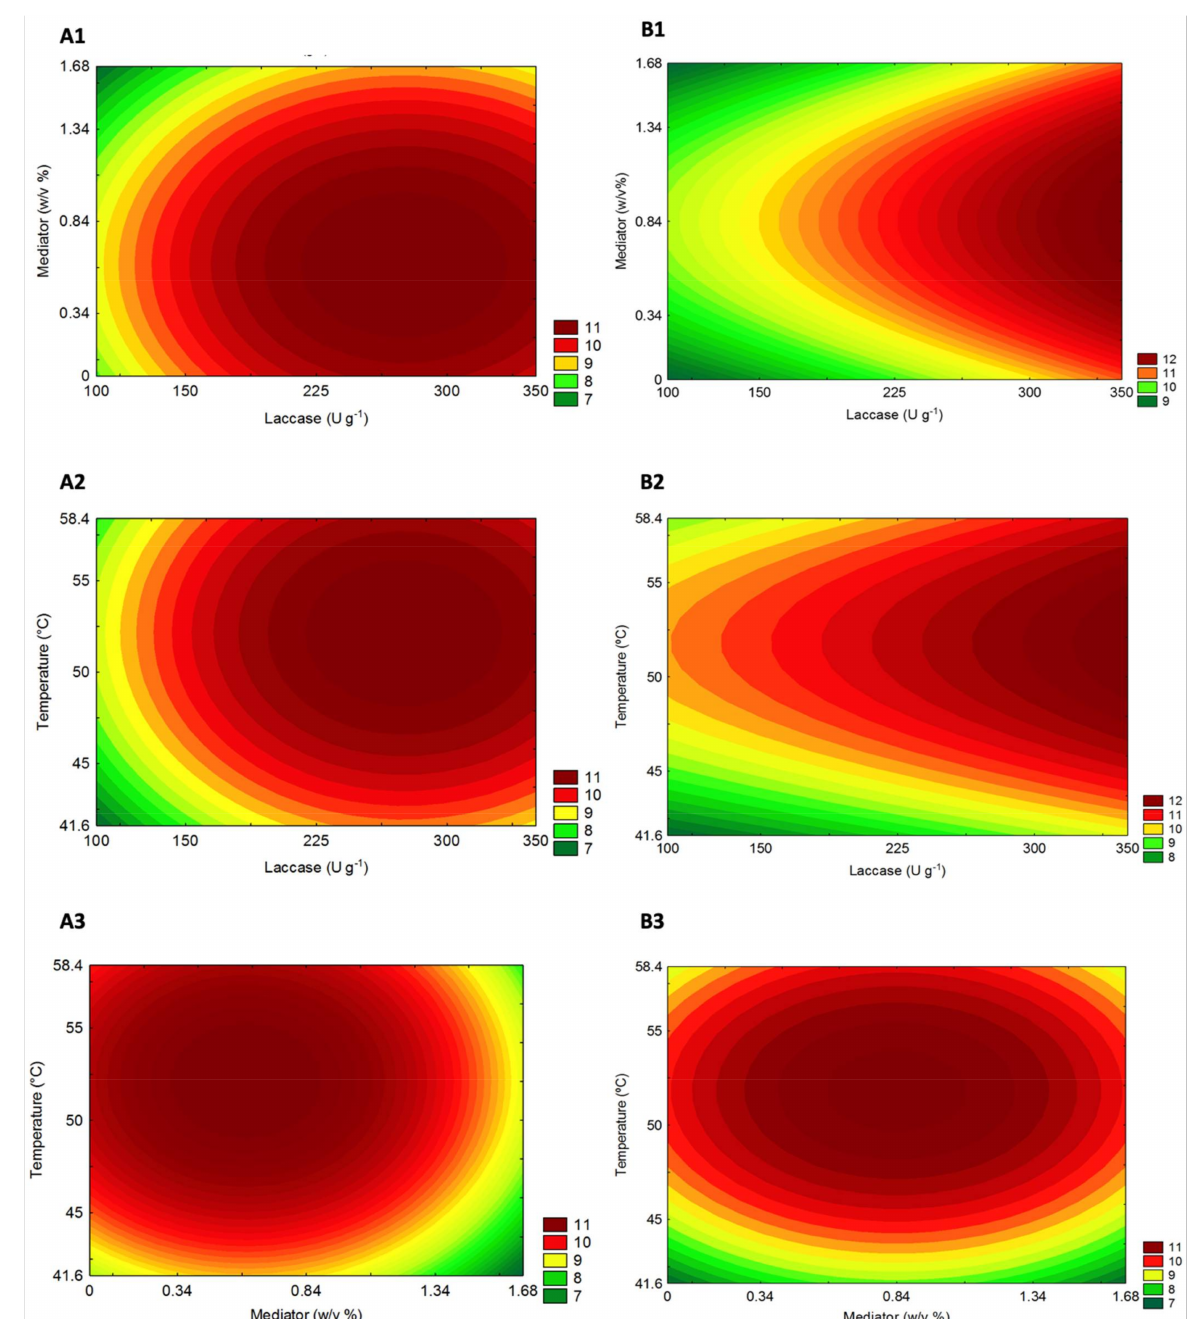
Figure 3. Panicum maximum response surfaces for the sugar yield obtained from hydrolysis after laccase pretreatment on ( A ) Control and ( B ) elevated temperature+elevated CO 2 (eT+eC). Correlations are shown between ( 1 ) Laccase and mediator, ( 2 ) Laccase and Temperature, and ( 3 ) Temperature and